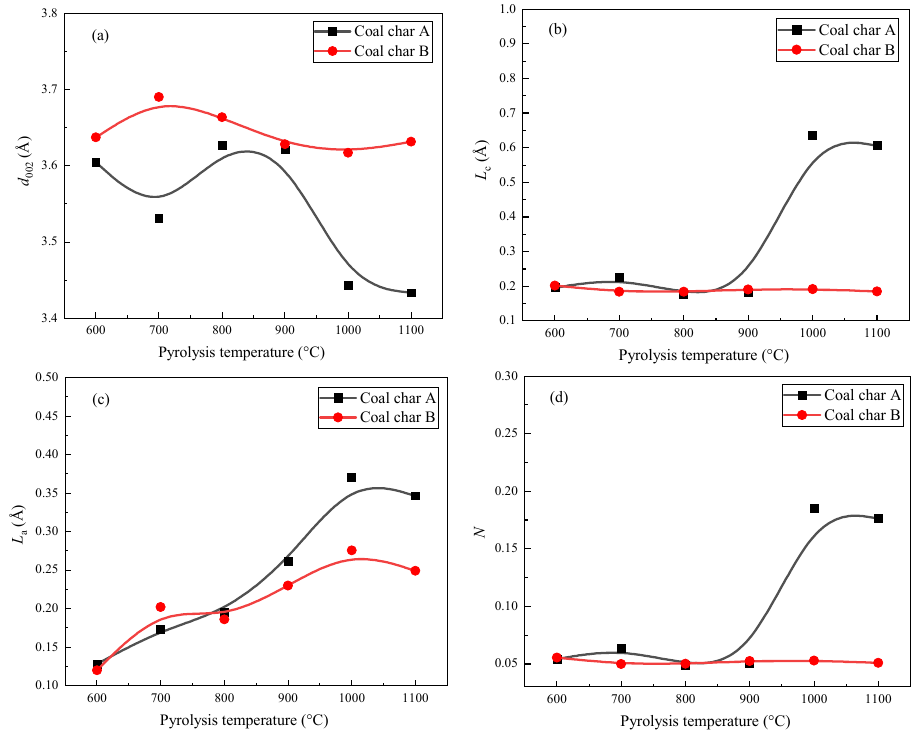
Figure 6. Variation of structural parameters of coal chars with pyrolysis temperature: ( a ) d 002 ; ( b ) L c ; ( c ) L a ; ( d ) N .